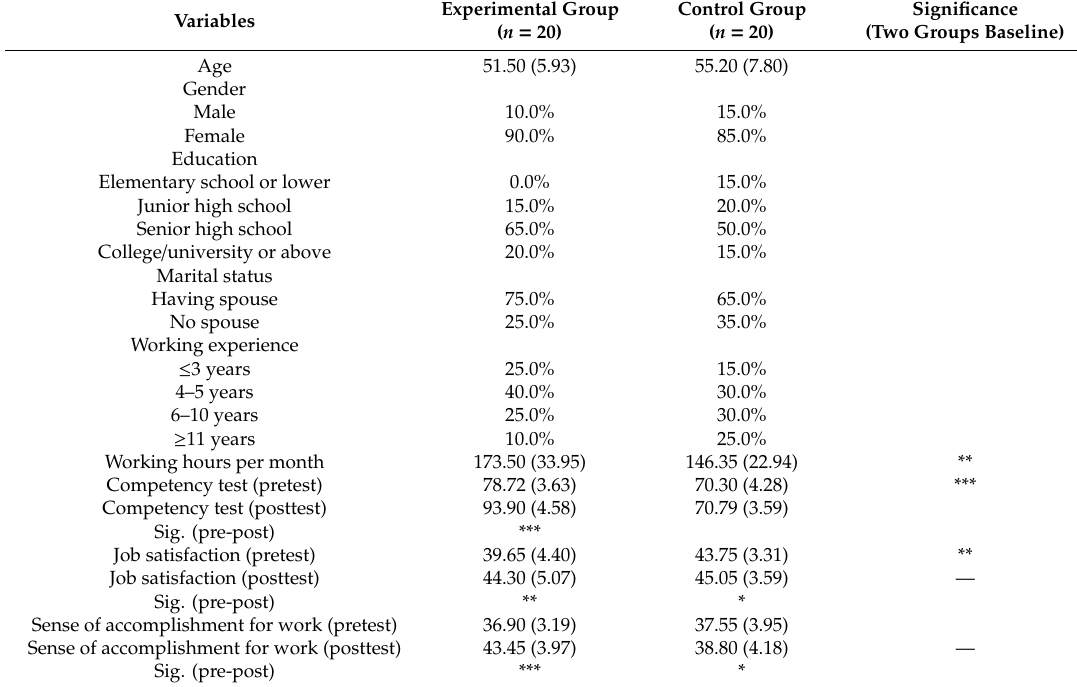
Table 2. Description of the sample: care attendants.